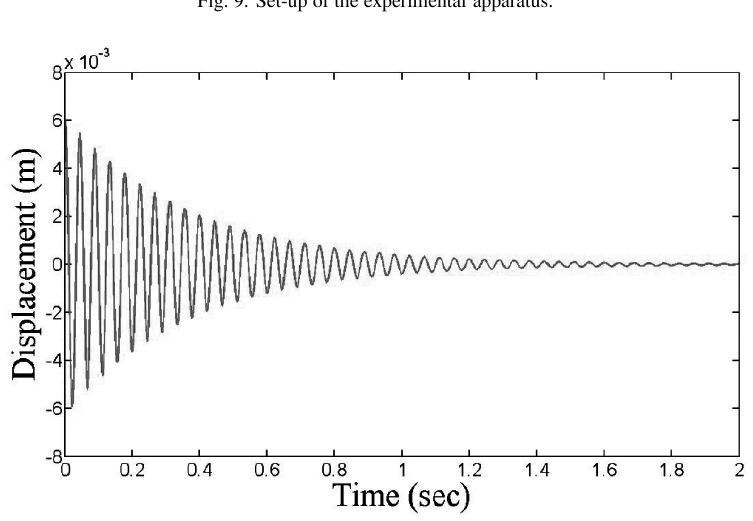
Fig. 10. Experimental time history of the cracked cantilever beam with α = 0.38 and β =